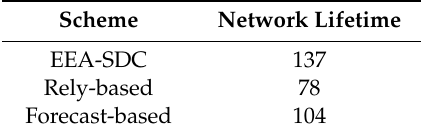
Table 3. Network lifetime hypothesis compared to relay and forecast-based schemes sensors.